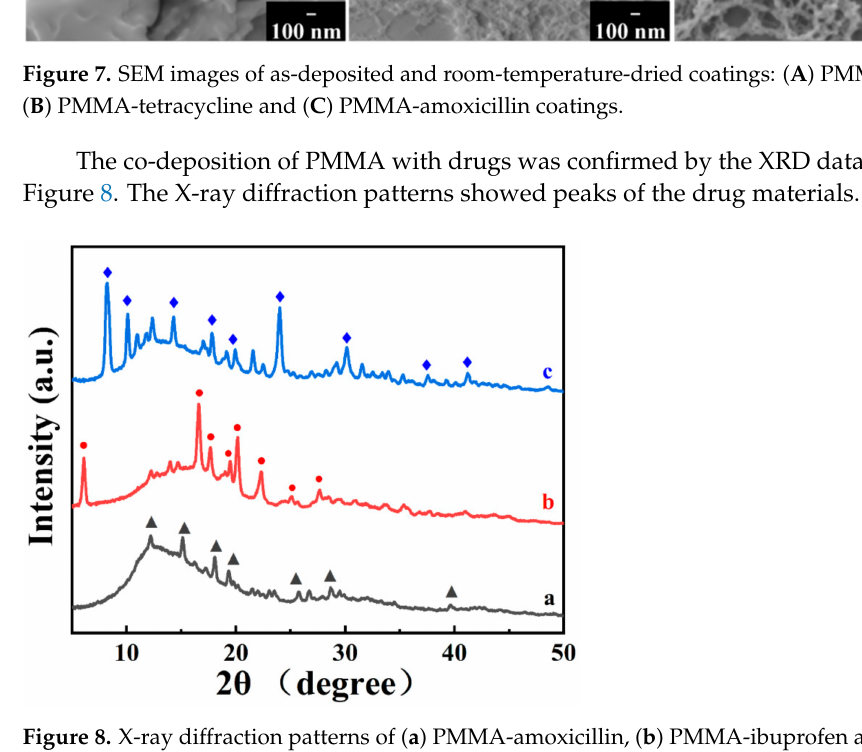
Figure 8. X-ray diffraction patterns of ( a ) PMMA-amoxicillin, ( b ) PMMA-ibuprofen and ( c ) PMMA- tetracycline; major XRD peaks are labeled: (cid:78) —peaks corresponding to JCPDS file 00-039-1832 of amoxicillin, • —peaks corresponding to JCPDS file 00-032-1723 of ibuprofen, (cid:7) —peaks corresponding to JCPDS file 00-039-1985 of